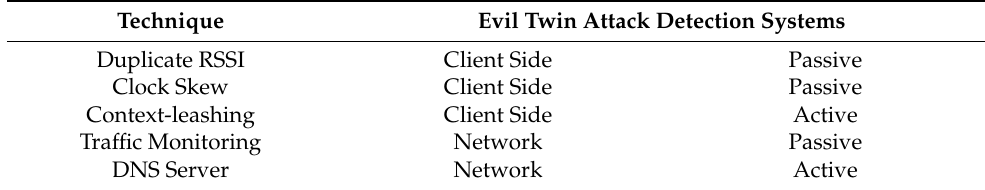
Table 1. Comparisons of different evil twin attack detection techniques.